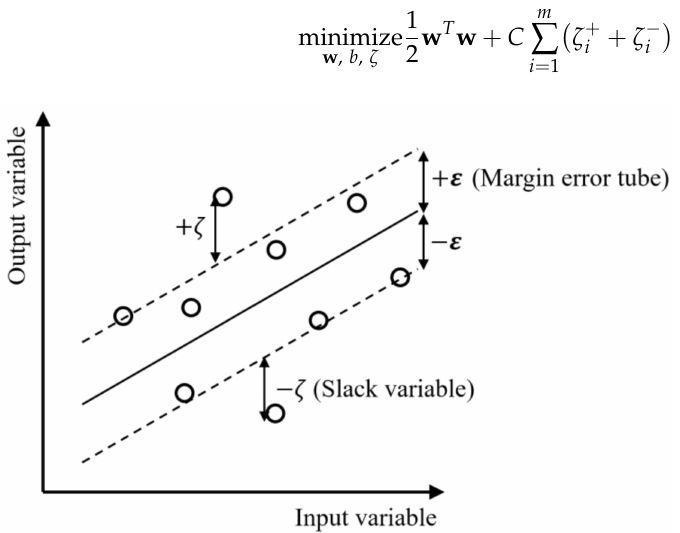
Figure 7. Concept of support vector regression. It learns to include as many datasets as possible in a limited ε -tube and a constraint of the slack variable. Even if the training set is newly added, the errors are regarded as zero within the allowed ε . However, if the training set is outside the ε -tube, a non-zero value of the slack variable ( ζ ) occurs, which indicates the degree of margin